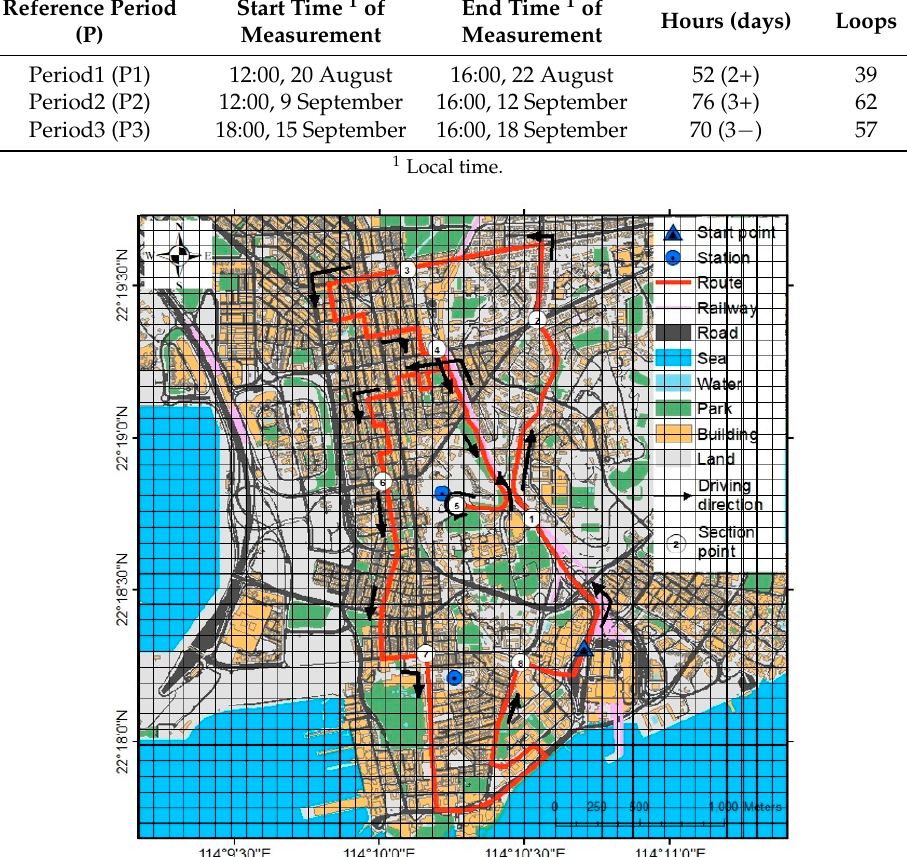
Figure 4. The illustration of the cell among the route.